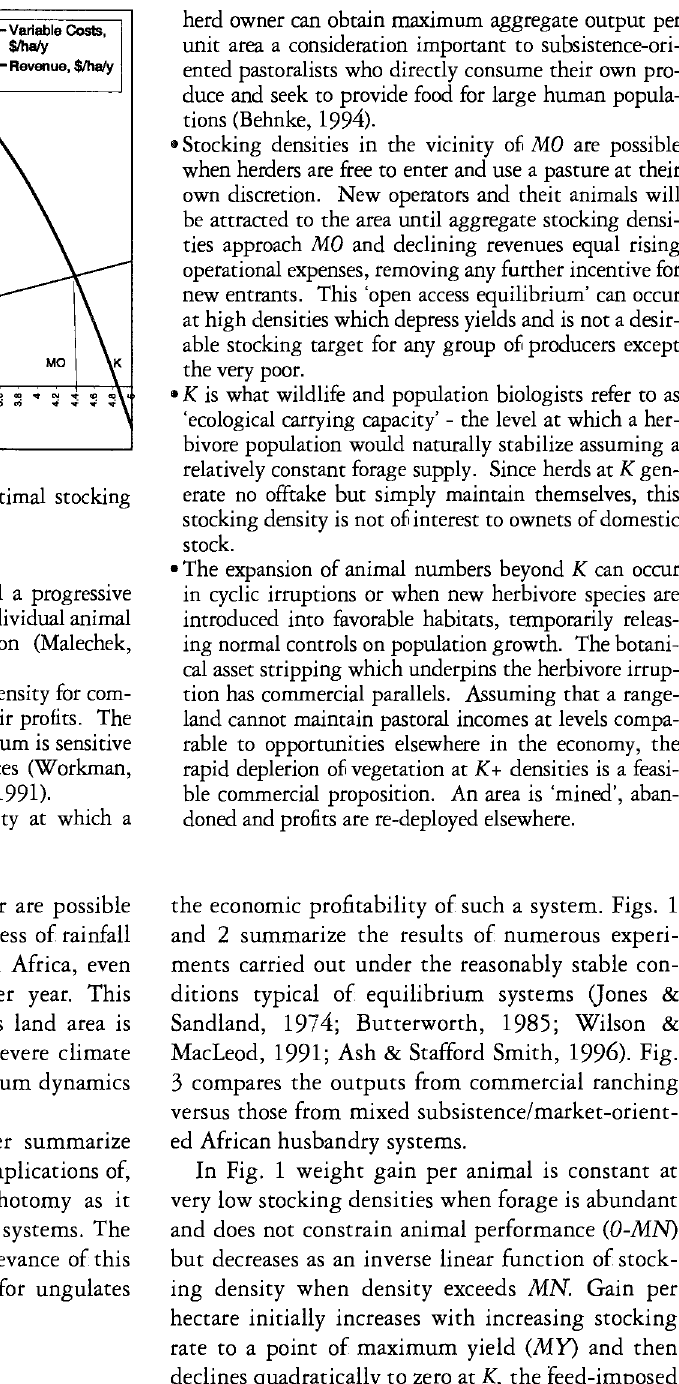
Fig. 2 converts physical outputs in Fig. 1